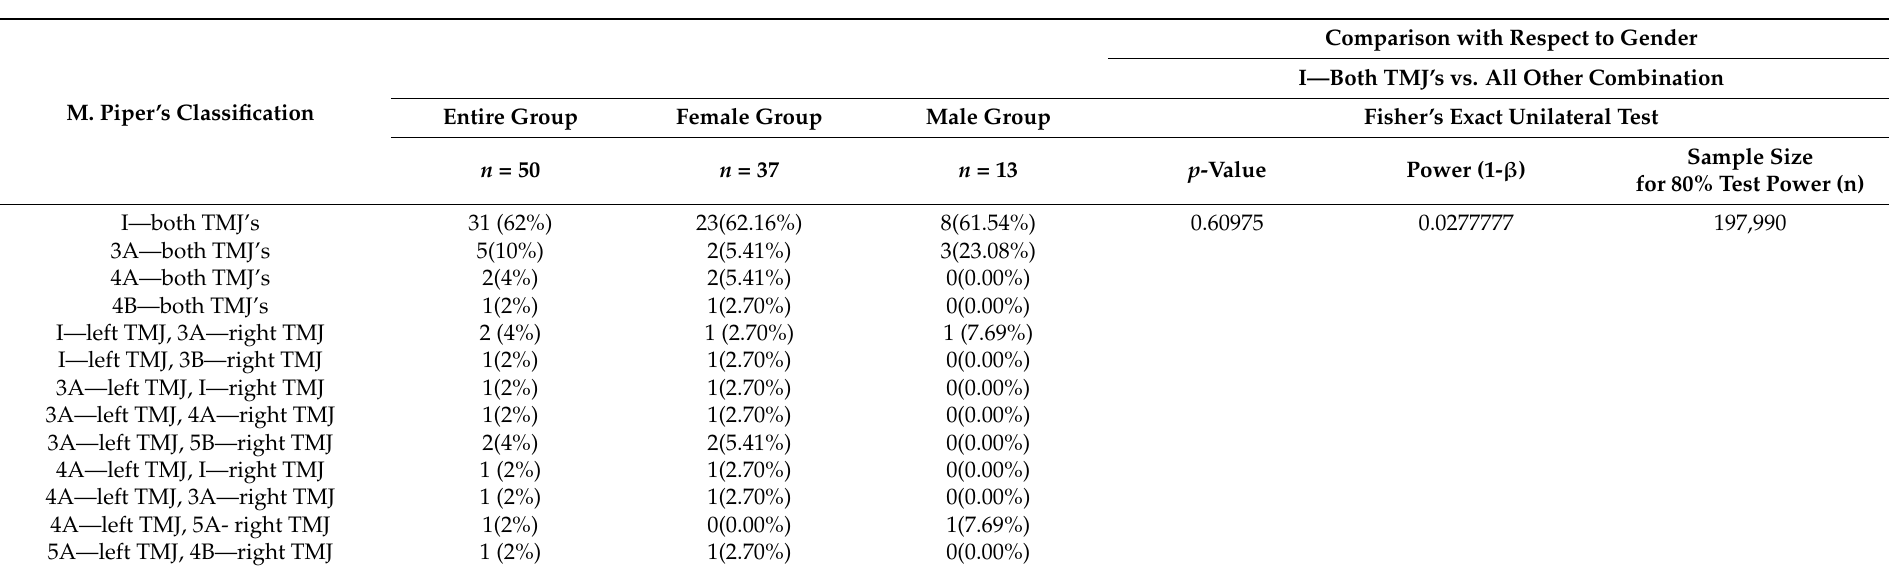
Table 2. The prevalence of combined bilateral diagnosis of temporomandibular dysfunction with respect to M. Piper’s classification model in the entire group ( n = 100), the female group ( n = 74) and the male group ( n =